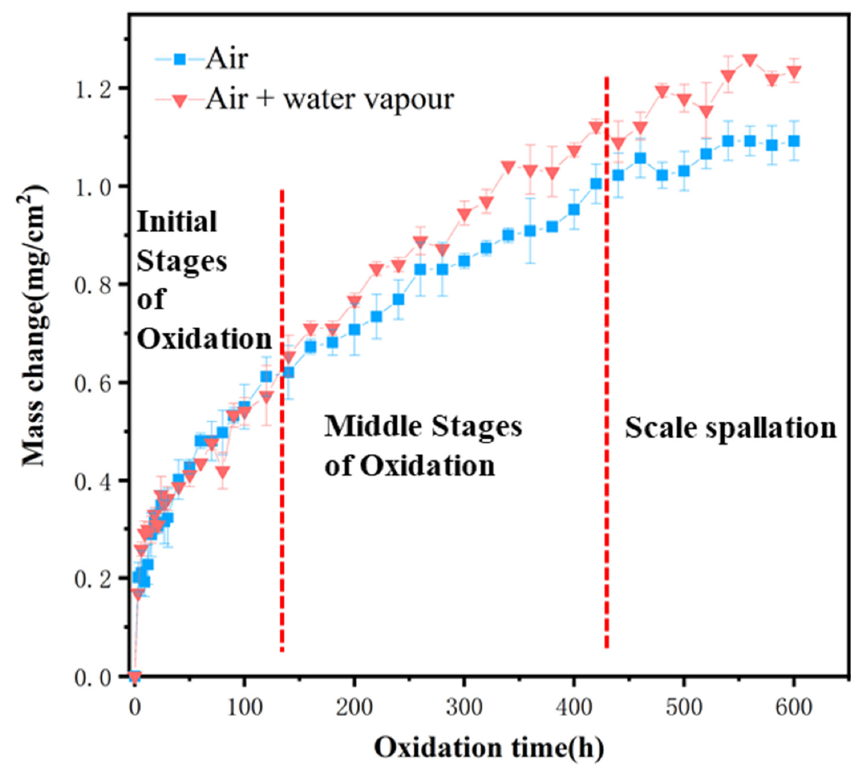
Figure 5. Mass gain curves of NiCrAlYHf sample after oxidation at 1100 °C for 600 h.